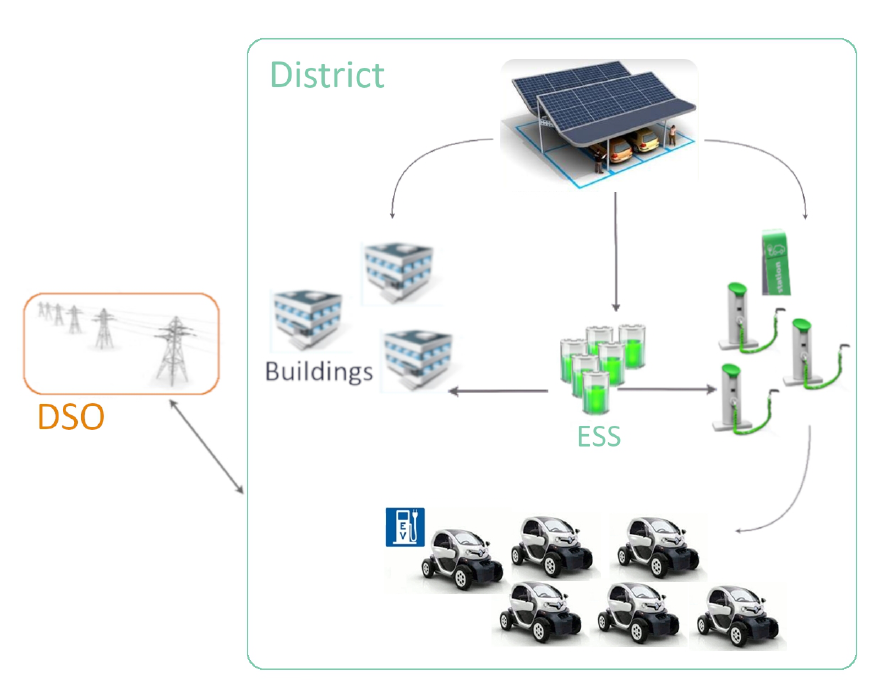
Figure 1. This figure shows the graphic representation of the pilot